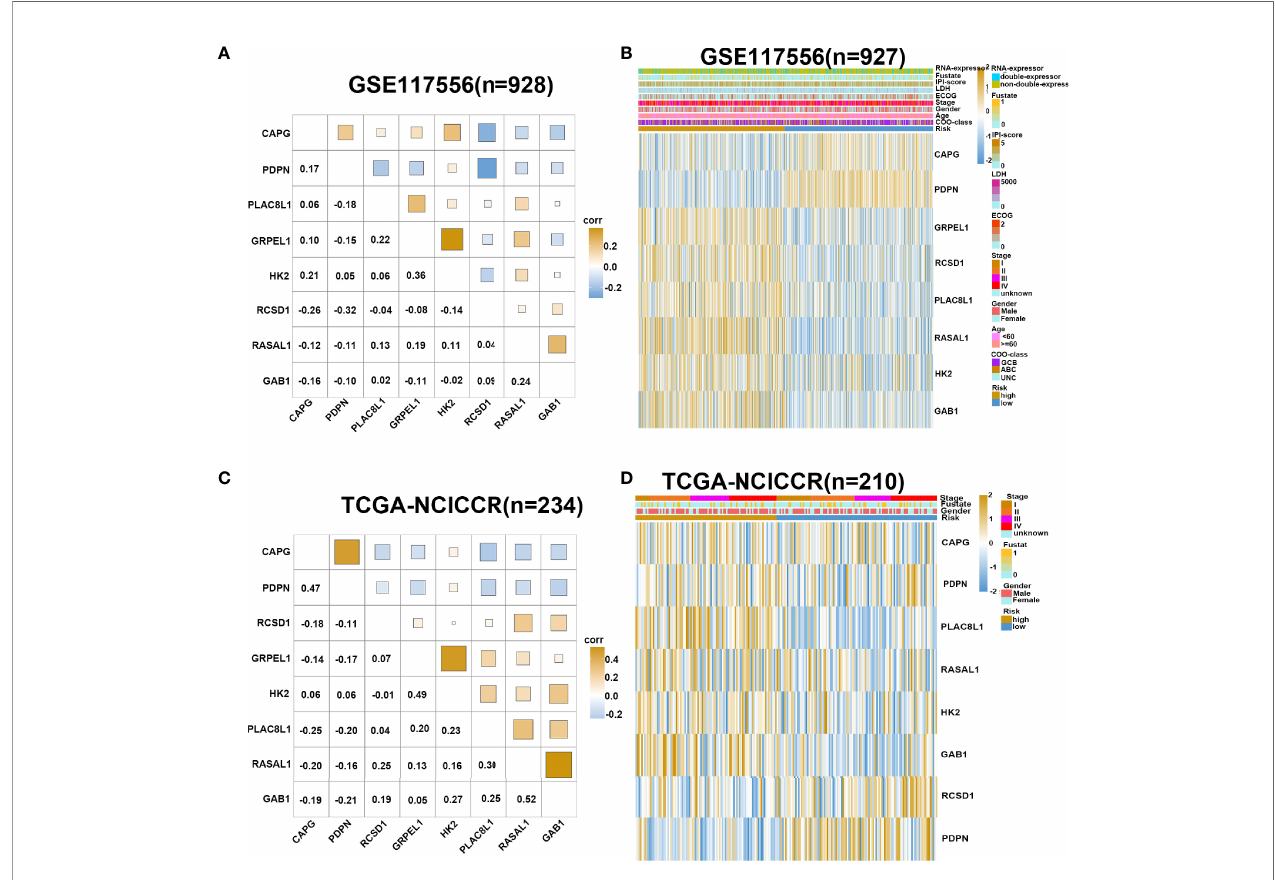
FIGURE 3 | Gene expression in high- and low-risk group. (A) Corrplot shows correlation of eight genes in GSE117556 dataset. (B) Heatmap shows gene expression of eight genes and clinical parameters in high- and low-risk group in GSE117556 dataset. (C) Corrplot shows correlation of eight genes in TCGA- NCICCR dataset. (D) Heatmap shows gene expression of eight genes and clinical parameters in high- and low-risk groups in TCGA-NCICCR